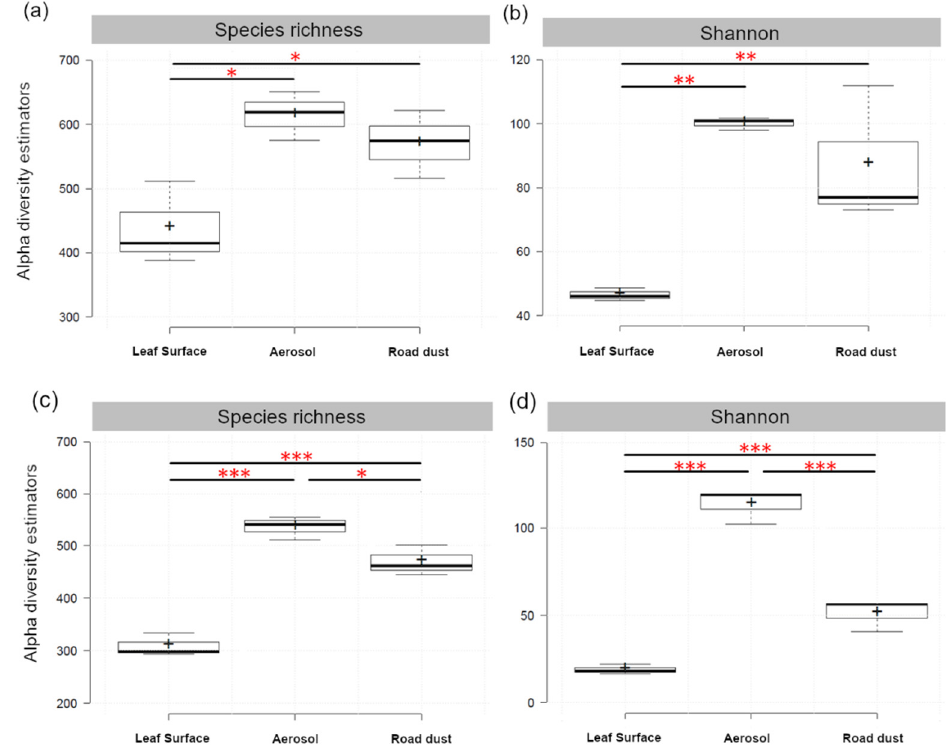
Figure 2. Statistical comparisons of OTUs richness (Species Richness, S *) and diversity (exponential of Shannon entropy, 1 D* ) of bacterial ( a , b ) and fungal ( c , d ) communities across three types of samples, leaf surface of Q. ilex , aerosol (PM 10 ) and road dust, collected in three urban sites of Rome. Pairwise comparisons of least square means were performed using Tukey’s HSD test, and the horizontal lines show significance levels between groups (* p < 0.05, ** p < 0.01, *** p < 0.001).